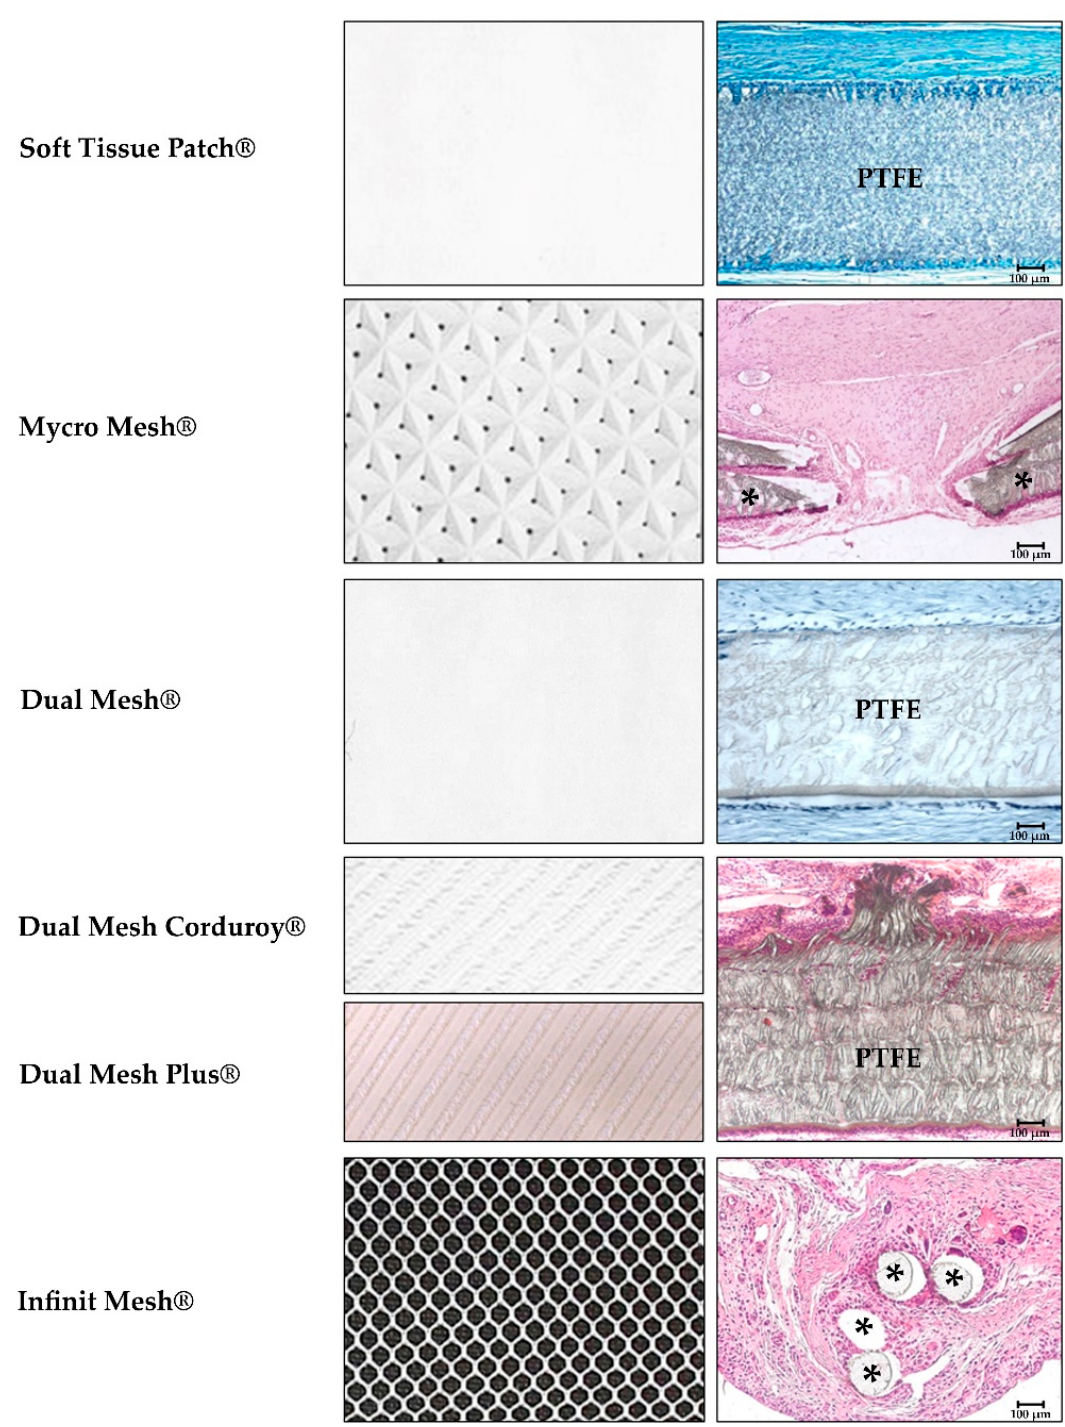
Figure 1. Macroscopic images of the different modifications in polytetrafluoroethylene (PTFE) meshes ( left ) and host tissue incorporation once implanted ( right ). Both surfaces, subcutaneous and peritoneal sides of the PTFE implants (Soft tissue Patch ® , Dual mesh ® , Dual Mesh Corduroy ® -Dual Mesh Plus ® , 30, 14, and 90 days post-implant, respectively, 100×) were encapsulated by host connective tissue. Scar tissue surrounds the PTFE implants, and some cells could be seen into the prosthetic interstices, at the inner third of the PTFE. Furthermore, in Mycro Mesh ® , host tissue penetrates through the material micropores (60 days post-implant, 100×). Infinit Mesh ® behaviour was similar to reticular meshes integration, like polypropylene, with connective tissue surrounding the mesh filaments (14 days post-implant, 100×). Scale bar: 100 μ m.